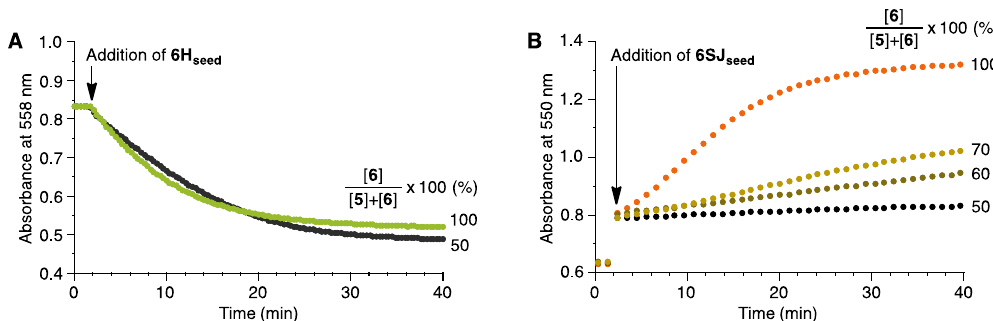
Figure 7. Kinetic studies of seeded growth. Time courses of seeded growth of ( A ) H aggregate and ( B ) short- slipping J aggregate monitored as changes in absorbance at 558 and 550 nm, respectively. Seeds of H and